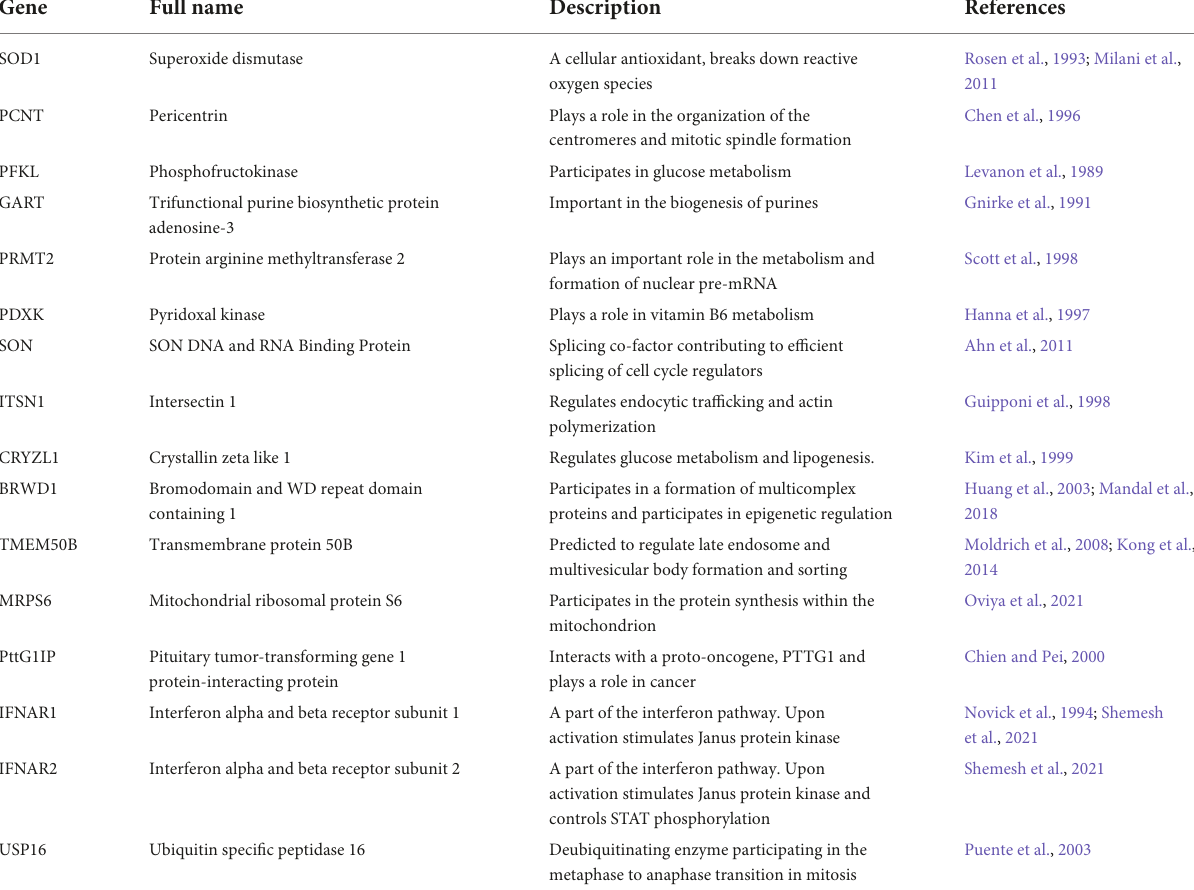
TABLE 2 Sixteen differentially expressed (DEX) genes on HSA21 that were present in all four